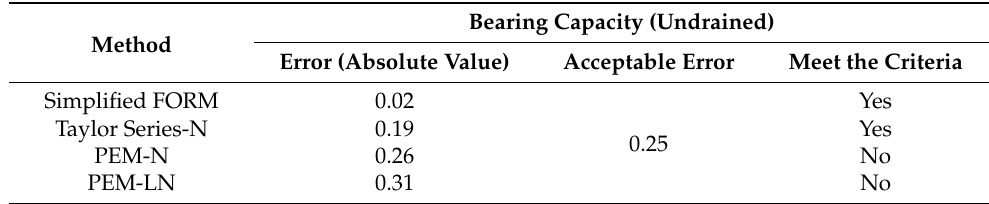
Table 11. Reliability methods suitability assessment in the case of retaining wall [2] according to the proposed